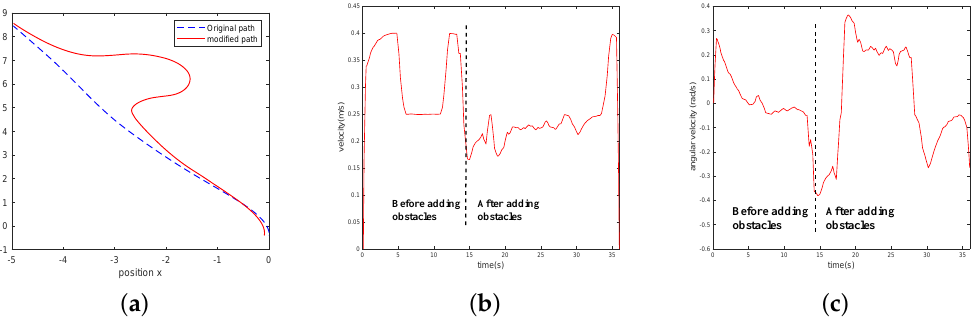
Figure 11. The results before and after adding virtual obstacles in experiment II. ( a ) Trajectory comparison before and after adding obstacles. ( b ) Change in velocity before and after adding obstacles. ( c ) Change in angular velocity before and after adding obstacles.